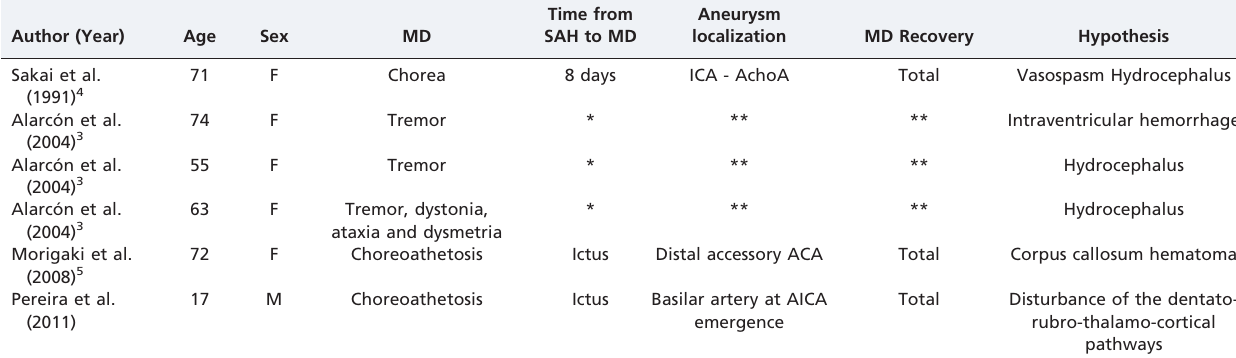
Table 1 - Movement disorders after